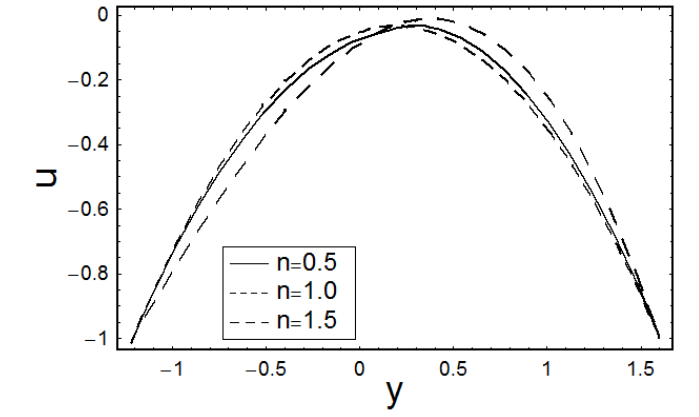
Figure 9. Plot of u for n with a = 0.6, b = 0.3, d = 1.0, φ = π /4, Θ = 1, x = 0 and b ∗ =